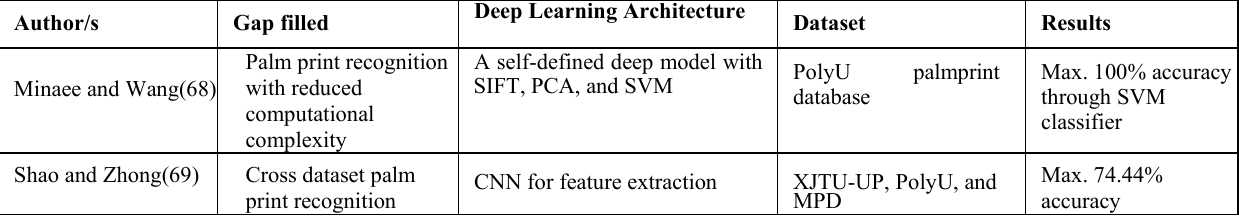
Table 8. Important works on palmprint based identification using deep learning.